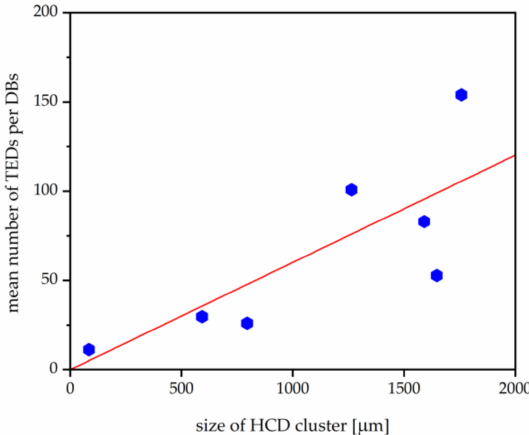
Figure 9. Correlation between the number of TEDs in the DBs located in the corners of the HCD and the size of the HCD clusters: the larger an HCD cluster, the higher the number of TEDs in the corresponding six DBs. The blue hexagons represent the data points and the red line is a guide for the